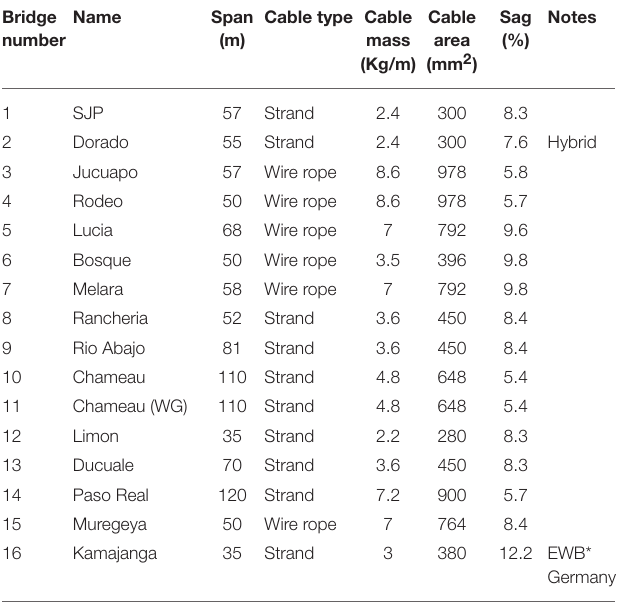
TABLE 4 | Design parameters of B2P footbridges.